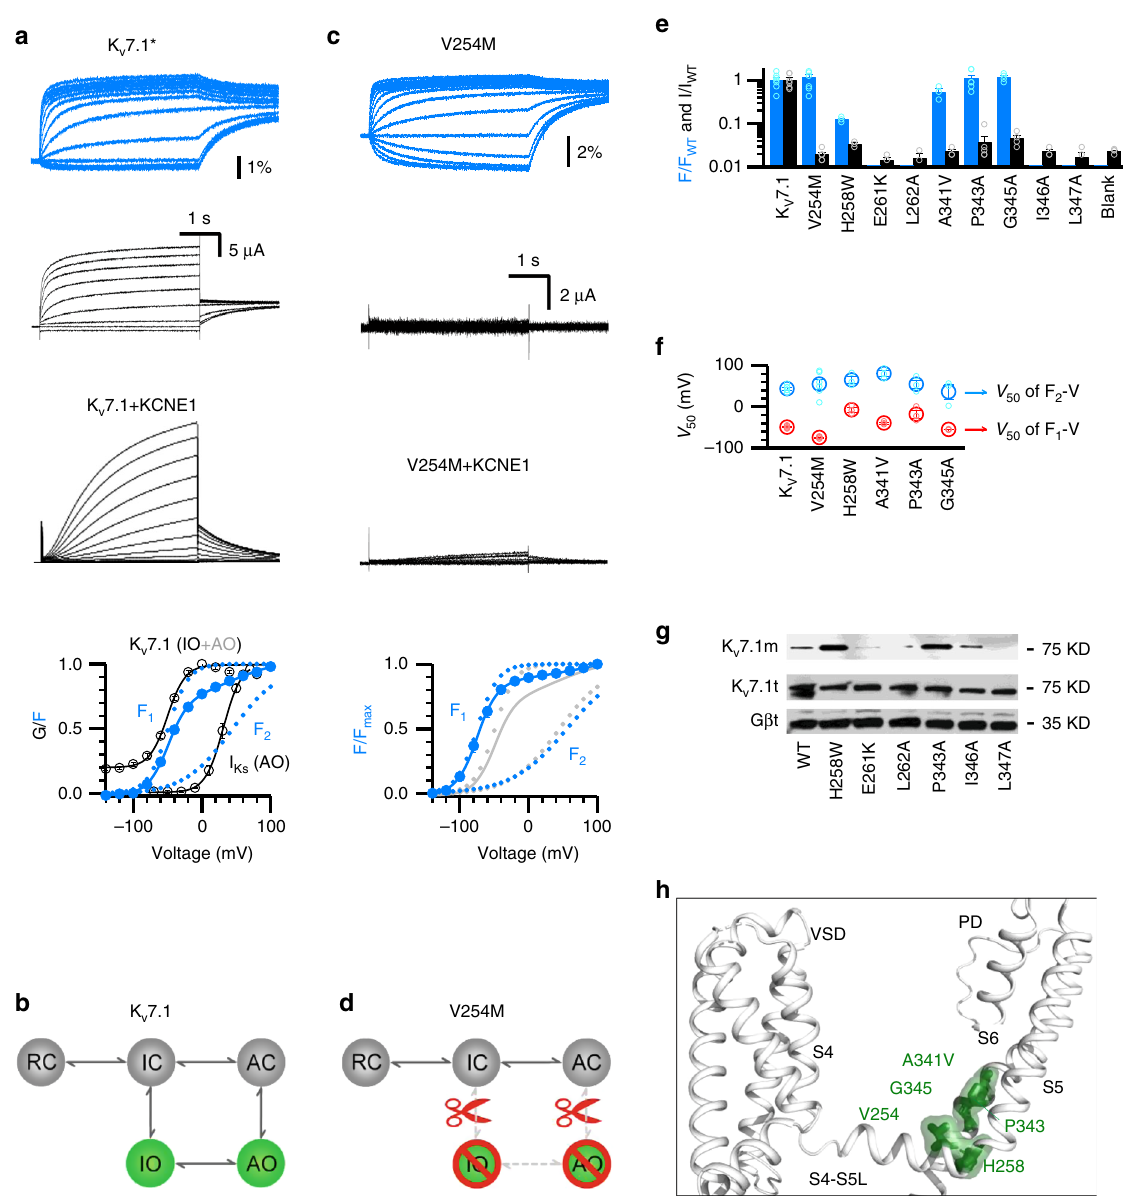
Fig. 1 Classic interactions are necessary for E – M coupling when the VSD transitions into the intermediate state. a VCF recordings of pseudo-WT K V 7.1* (K V 7.1-C214A/G219C/C331A). K V 7.1 + KCNE1 currents are shown at the same scale. The F – V relationships (blue circles) are fi tted with a double Boltzmann function. F 1 – V represents the VSD transition from resting to intermediate state; F 2 – V represents the VSD transition from the intermediate to activated state. G-V represents channel opening with VSD transition at both the intermediate (IO) and the activated (AO) states. b Cartoon scheme illustrating the gating mechanism of two-step VSD movements and distinct two open states. c VCF recordings of V254M in K V 7.1*. V254M + KCNE1 currents are shown at the same scales. The F – V relationships of K V 7.1* and V254M are shown in gray and blue, respectively. d Cartoon scheme illustrating that V254M disrupts E – M couplings for both IO and AO. e Summary of data for WT and mutant K V 7.1. VSD activation (blue, percentage change in fl uorescence) and pore opening (black, current amplitude) are normalized to the WT. n ≥ 3. Blank: cells not injected with channel mRNA. Data points are shown in small open circles. f V 50 values for the F 1 – V and F 2 – V. n ≥ 3. Data points are shown in small open circles. g Western blot results showing the membrane (top) and total (middle) expression of some mutants that eliminated both fl uorescence and ionic currents. G β (bottom) from total protein is shown as negative control. WT K V 7.1, H258W, and P343A are shown as positive controls. h Mapping the key residues V254, H258, A341, P343, and G345 (green) onto the S4-S5L/ S6c interface in the K V 7.1 cryoEM structure (PDB: 5VMS) 2 . All averaged data are shown in mean±SEM. Source data are provided as a Source Data fi